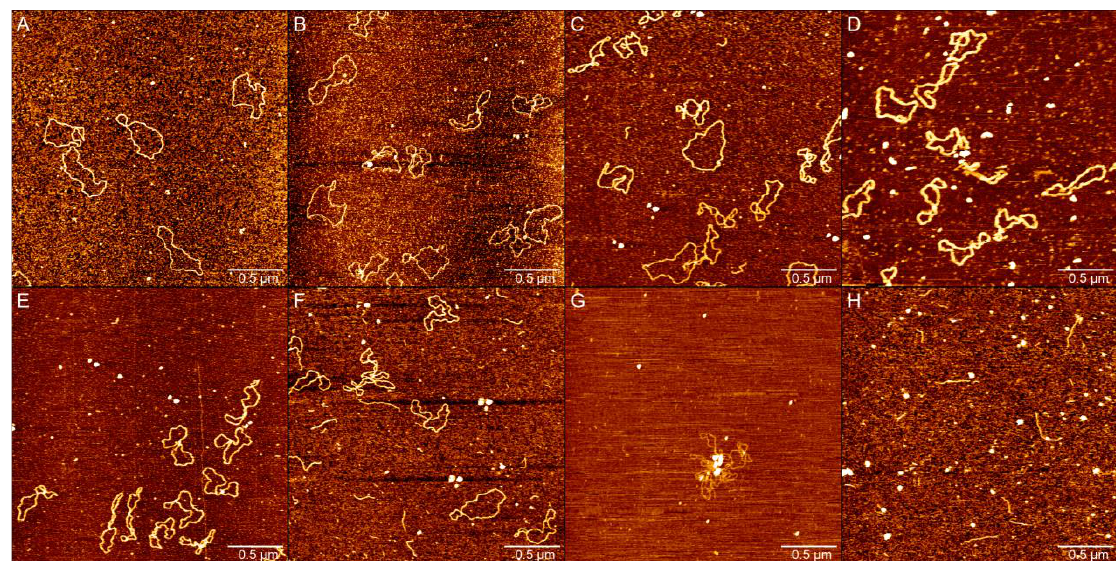
Figure 2. AFM images of pBR322 plasmids in deposition buffer (1 mM MgCl 2 , 10 mM HEPES (pH 7.5)) at different concentrations of PN. ( A ) Without PN. In ( B – H ), the concentration of PN is 50 µM, 100 µM, 150 µM, 200 µM, 300 µM, 400 µM, 1 mM.